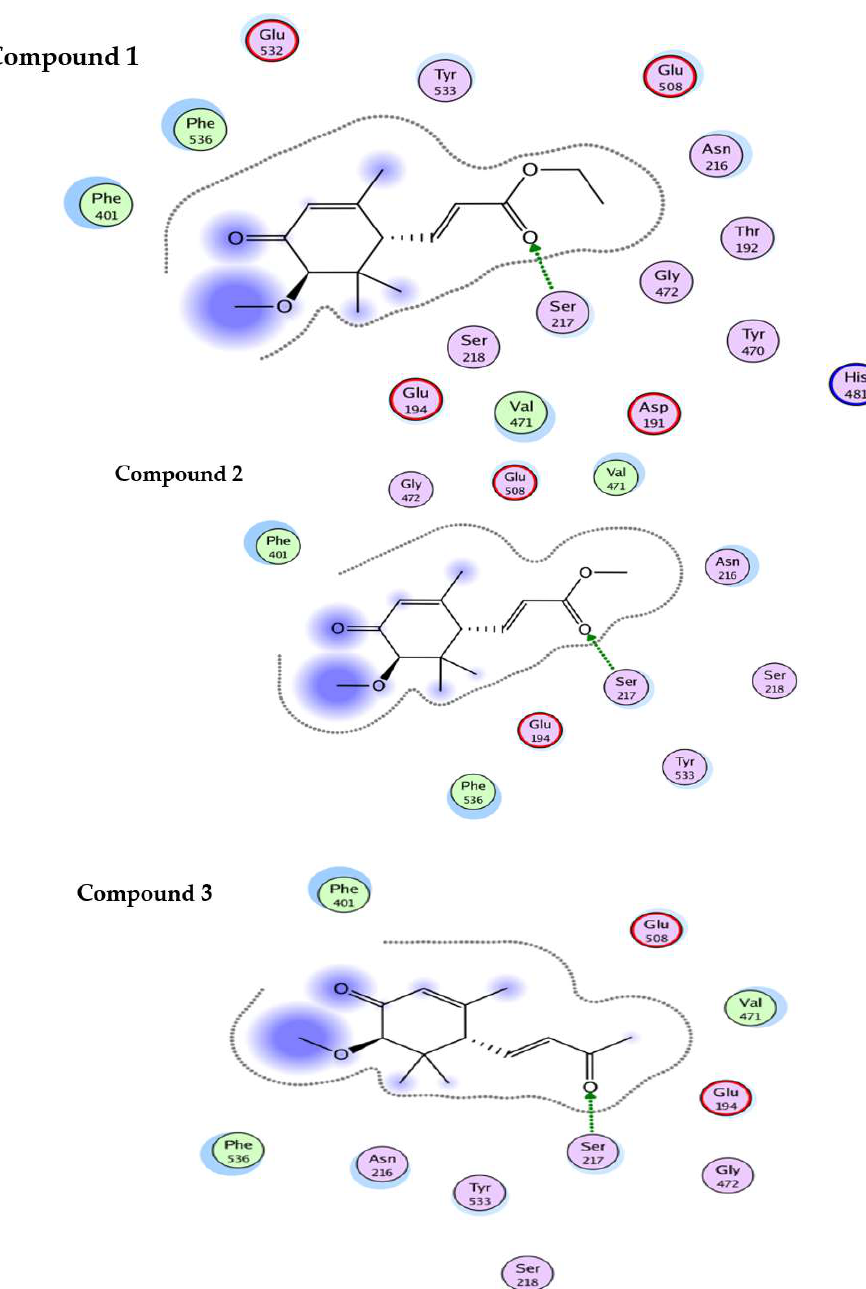
Figure 3. 2D interaction plot of compounds ( 1 – 3 ) with active site residues of α -glucosidase using LigX tools of MOE software. The three-letter amino acid code is assigned to each residue. Physical characteristics including HBA, HBD, total rotatable bonds, polar surface area, logP, and gastrointestinal absorption fit well into the criterion necessary for drug likeliness. Similarly, all the compounds strictly follow Lipinski rule, with minimum toxicity score of 4, as predicted by ProTox server (https://tox-new.charite.de/protox_II/index.php) (accessed on 4 May 2022) (Table